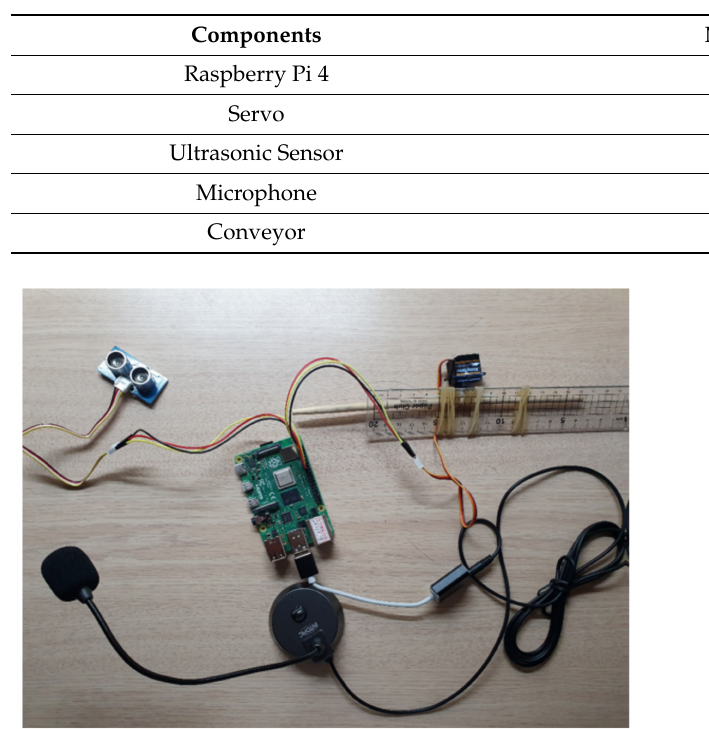
Table 1. Components used in developing the system.